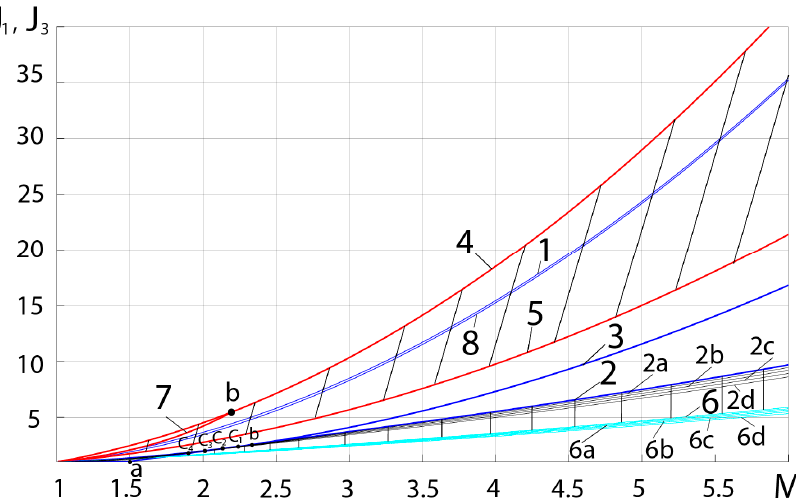
Figure 3. Special shock strengths. Curve 1 corresponds to maximum flow defection: J 1 = J l ( M ) , curve 2 corresponds to von Neumann criterion: J 1 = J N ( M ) , curve 3 corresponds to detachment criterion: J 1 = J d ( M ) , curve 4 corresponds to normal Mach shocks without pulsed energy release: J 3 = J m ( M ) , curve 5 corresponds to maximum pulsed energy release of the main shock: J 3 = J ∗ ( M ) , curve 6 corresponds to incident shocks forming SMCs at maximum pulsed energy release: J 1 = J 1 S ( M ) , curve 7 corresponds to Mach shocks in SMCs with maximum incident shock strength; curve 8 corresponds to critical flow velocity after the incident shock. Curves 2a–2d and 6a–6d describe the variation of maximum and minimum shock strength at SMCs when the adiabatic index changes at the main shock. Points c 1 – c 4 demonstrate the shift in Mach number M b of coincidence of the reflection type criteria at adiabatic index variation.